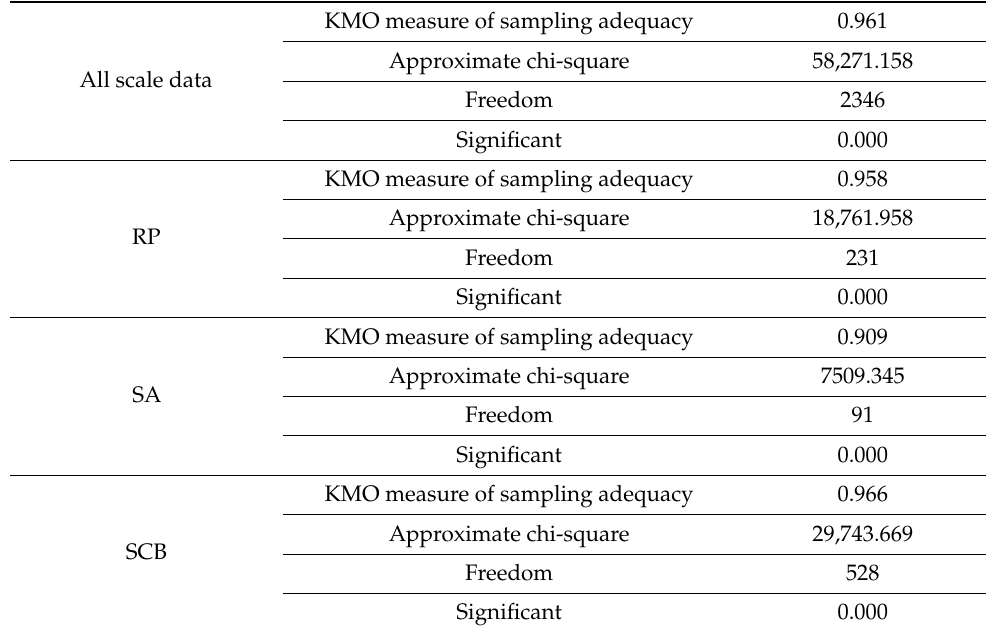
Table 3. KMO and Bartlett Test of Sphericity.